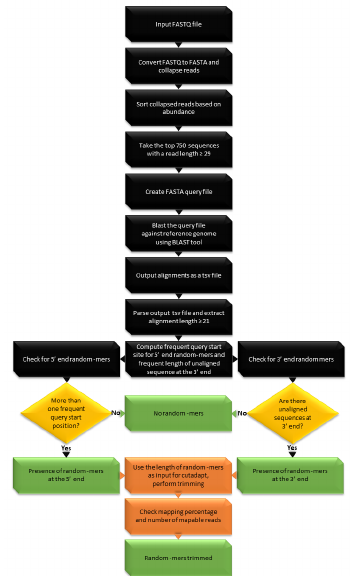
Figure 4. random_mer workflow. Black boxes: general procedure, green boxes: exit step, orange boxes: further recommended process, yellow diamonds: decision.